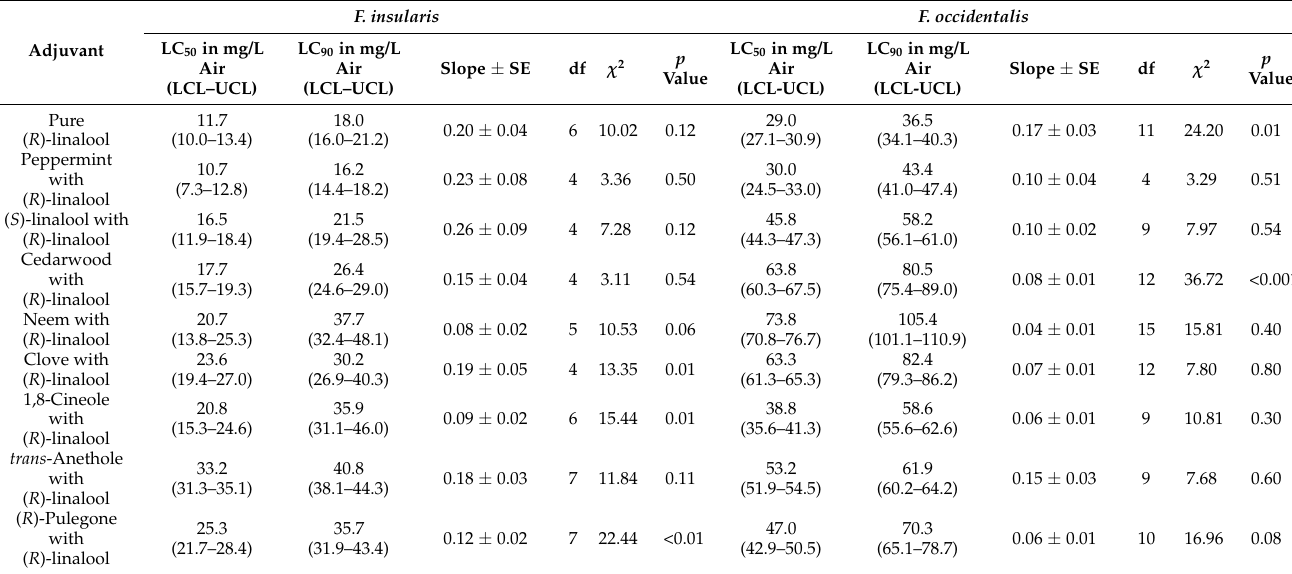
Table 2. LC 50 and LC 90 values for different adjuvants mixed with ( R )-linalool of F. insularis and F. occidentalis ( n =